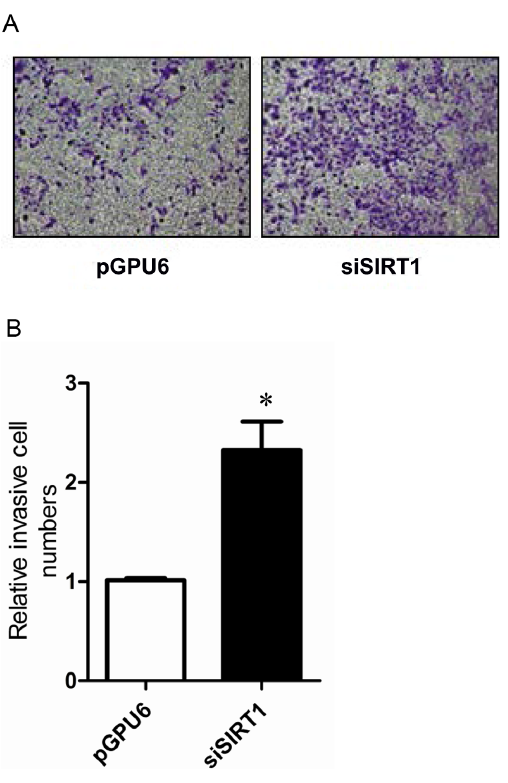
Figure 9. Effect of down-regulation of SIRT1 on PC-3 cell migration. ( A ) A transwell assay was used to measure the migration of cells transfected with pGPU6 or pGPU6-siSIRT1. ( B ) Number of cells penetrated the insert membrane. Data represent the mean value 6 SEM from three separate experiments. * P , 0.05 vs pGPU6.